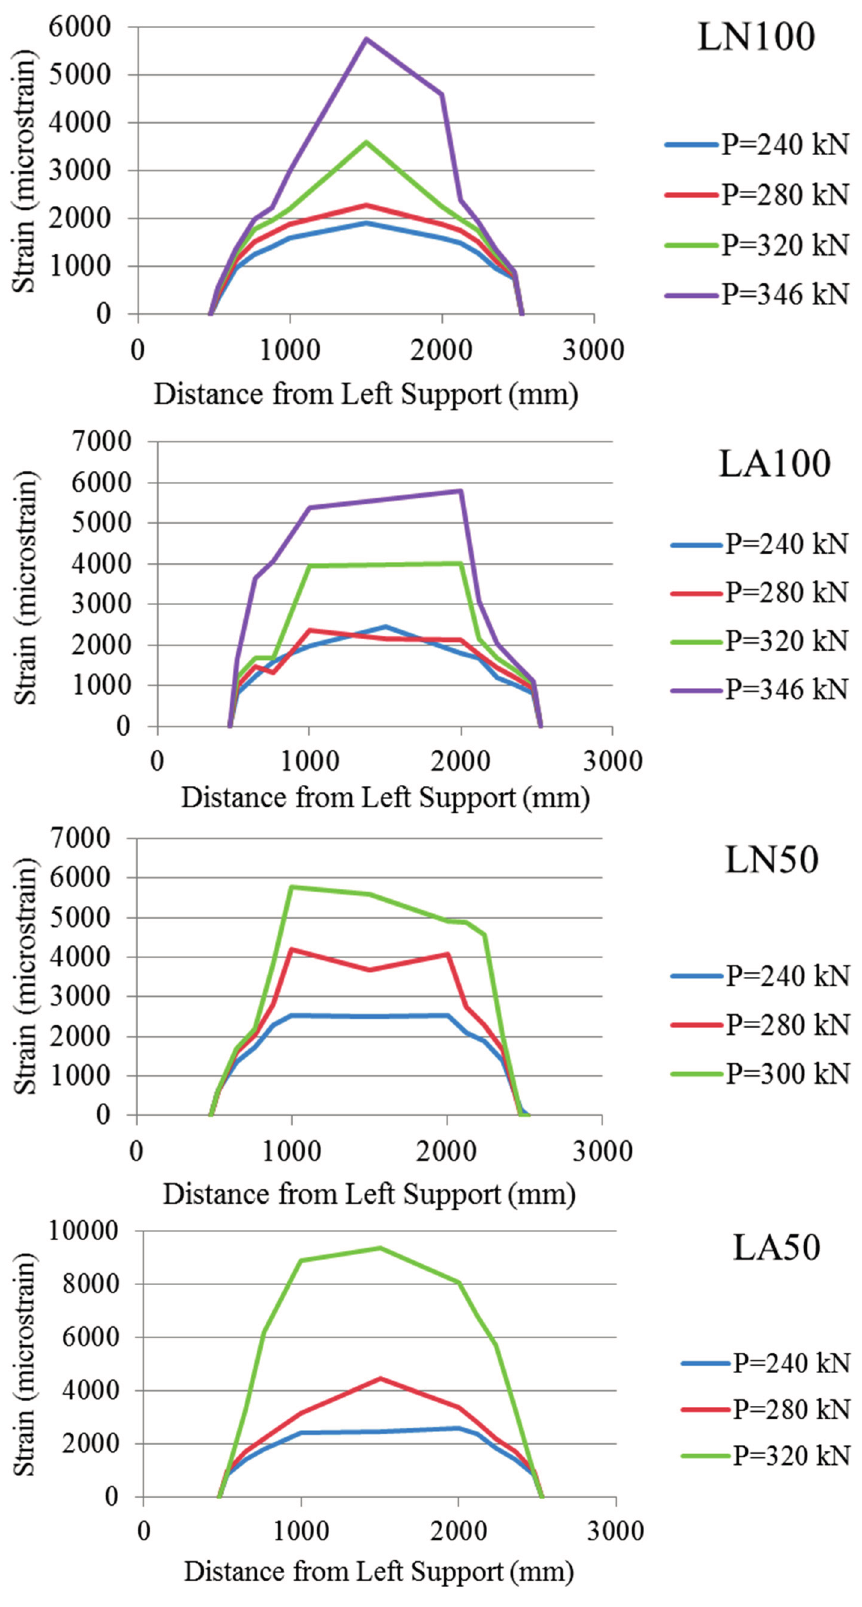
Figure 8. Strain variation along the FRP laminate in beams with and without